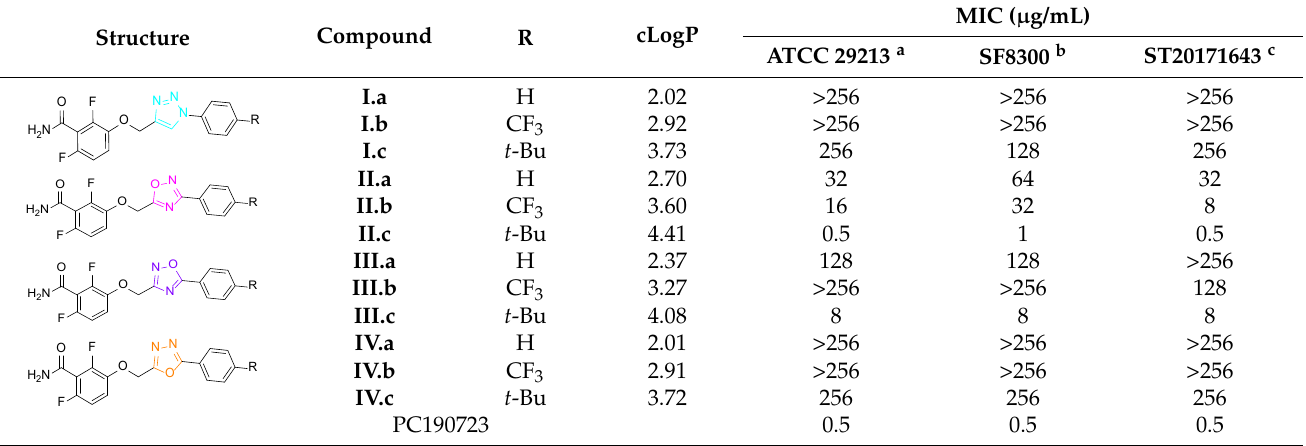
Table 1. Minimum inhibitory concentrations of series I , II , III, and IV molecules against S. aureus strains. Structure